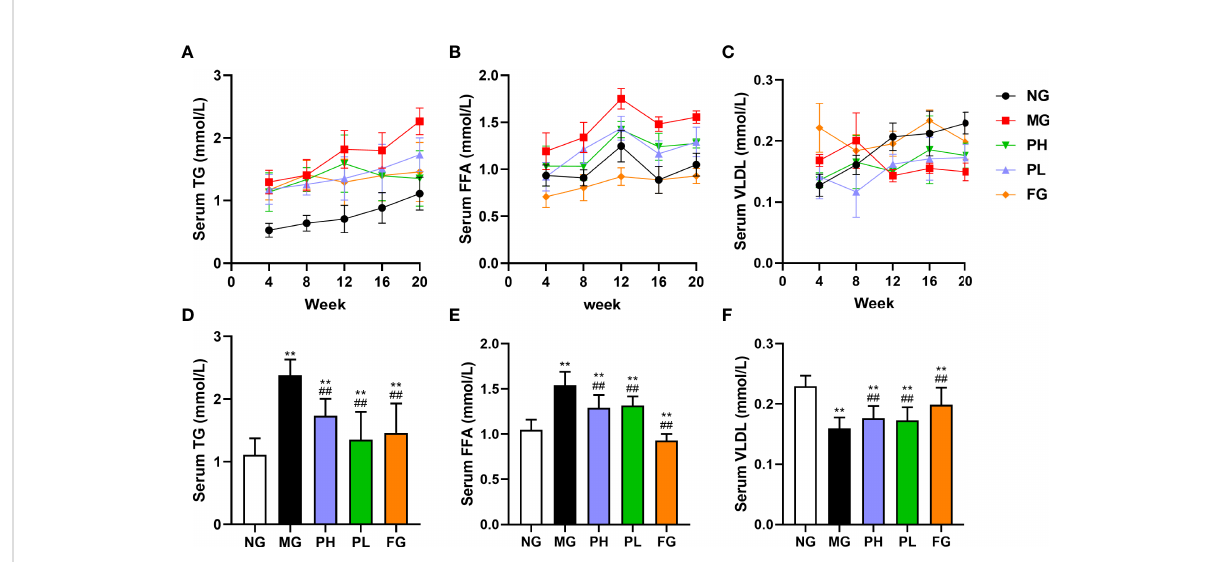
FIGURE 1 Effect of puerarin on serum lipid. (A) Changes in serum TG at 4 – 20 weeks; (B) changes in serum FFA at 4 – 20 weeks; (C) changes in serum VLDL at 4 – 20 weeks; (D) serum TG at 20 weeks; (E) serum FFA at 20 weeks; (F) serum VLDL at 20 weeks. Data were expressed as mean ± SD (n = 10). **p < 0.01, vs . NG; ## p < 0.01, vs .